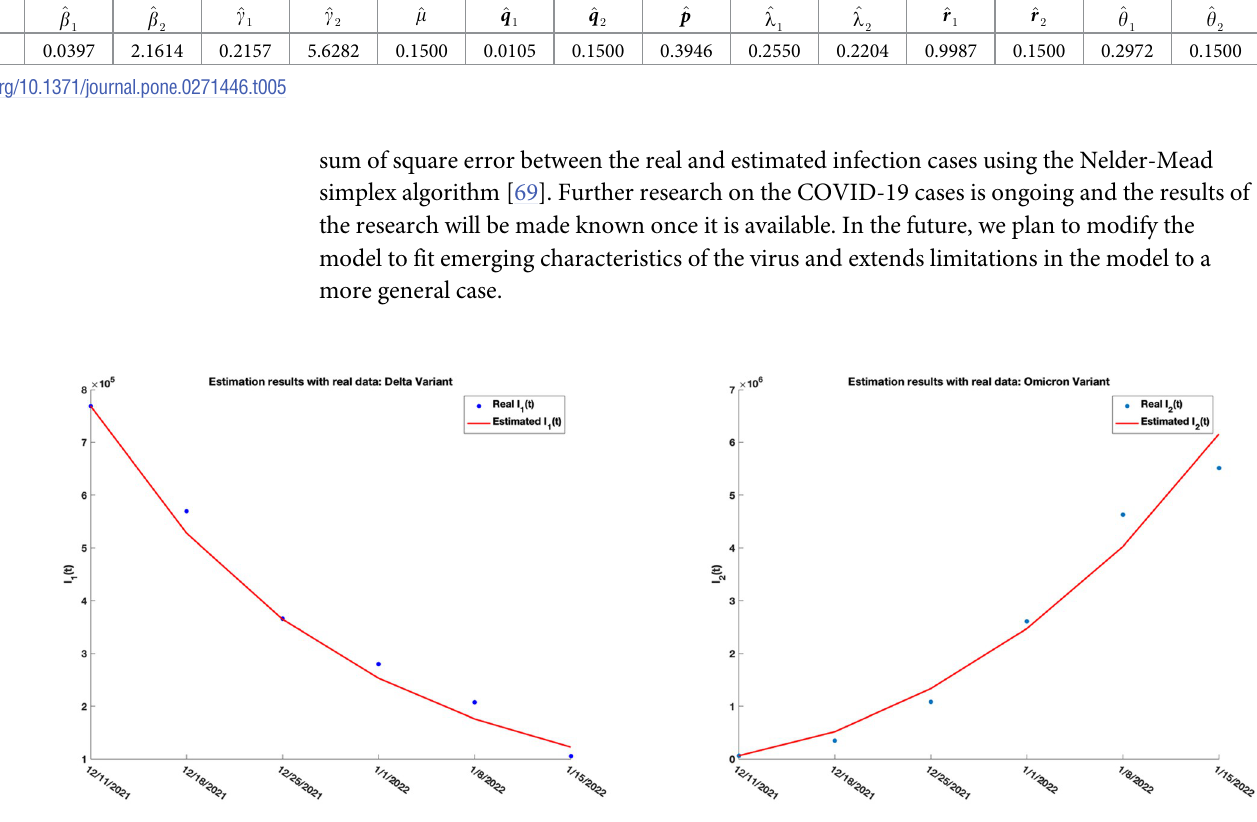
Fig 13. Real (dotted blue) and estimated (red) COVID-19 weekly cases for the Delta variant and the Omicron variant for the period 11.27.2021 to 01.15.2022 in the United States.